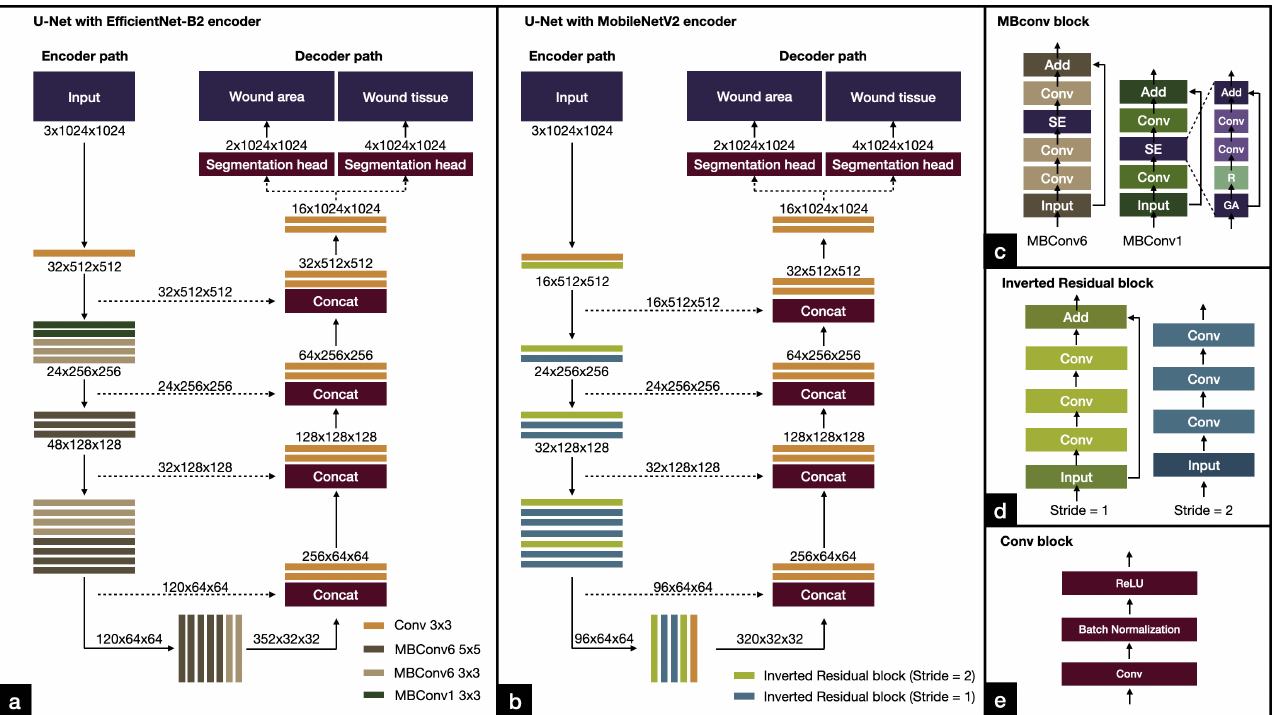
Figure 7. Architectures of our deep learning models. ( a ) U-Net with EfficientNet-B2. ( b ) U-Net with MobileNetV2. ( c ) MBConv block used by the EfficientNet-B2 encoder. ( d ) Inverted residual block used by the MobileNetV2 encoder. ( e ) Conv